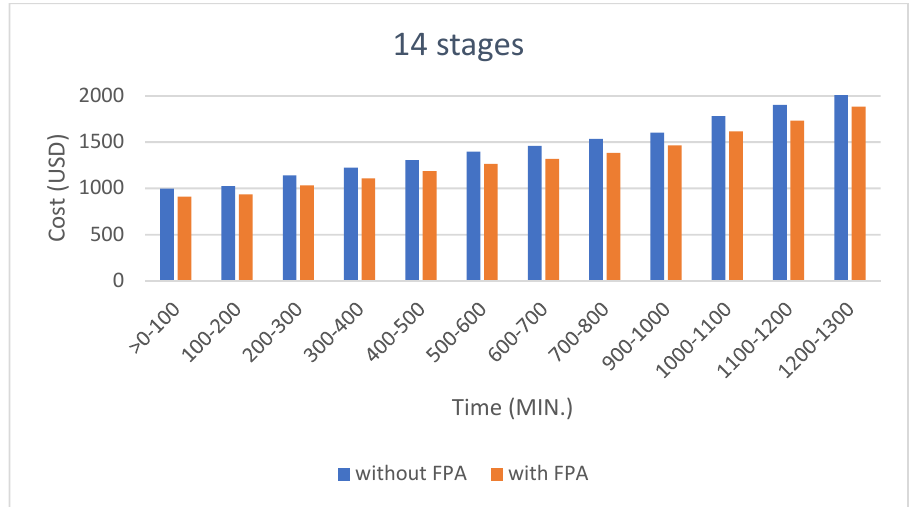
Figure 9. Comparison of Results for 14 stages with and without FPA.